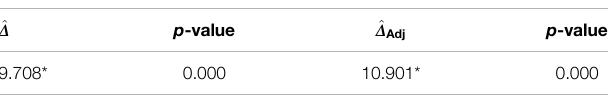
TABLE 4 | Slope Heterogeneity Test.